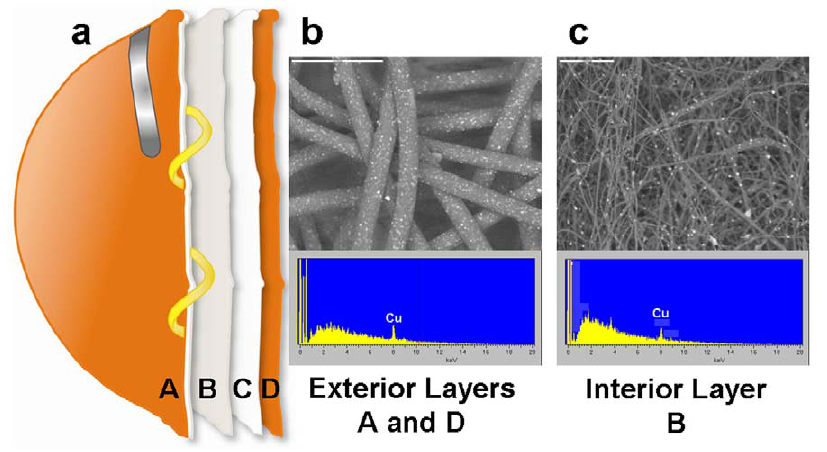
Figure 1. Copper oxide impregnated test mask composition. a) The test mask was composed of 2 external spunbond polypropylene layers (A and D) containing 2.2% copper oxide particles (weight/weight), one internal meltblown polypropylene layer (B) containing 2% copper oxide particles (w/w) and one polyester layer containing no copper oxide particles. b) Scanning electronic microscope picture and X-ray analysis of external layer A. c) Scanning electronic microscope picture and X-ray photoelectron spectrum analysis of internal layer B.